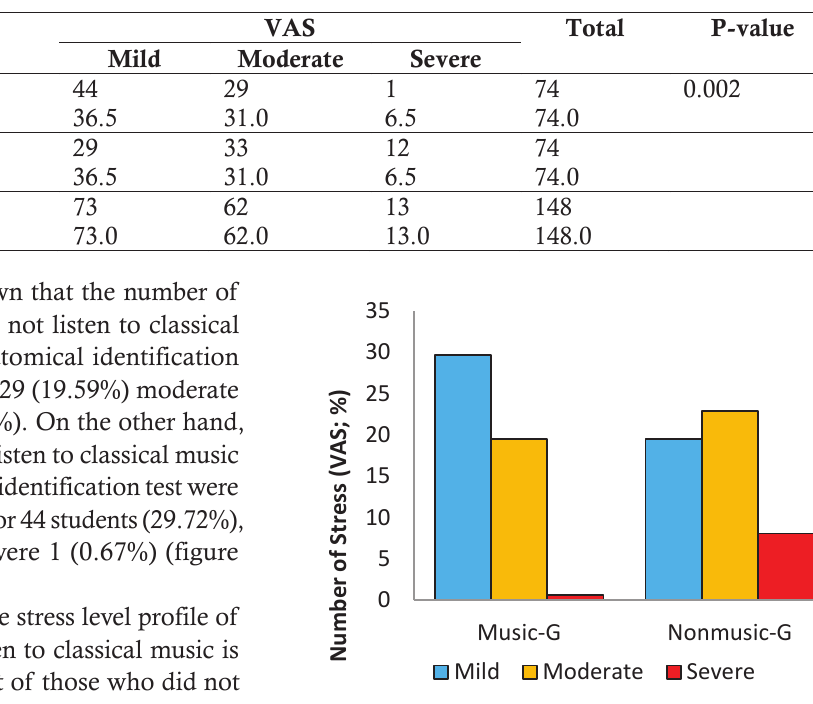
Table.2. Table of cross influence of listening to classical music on stress alleviation in students while